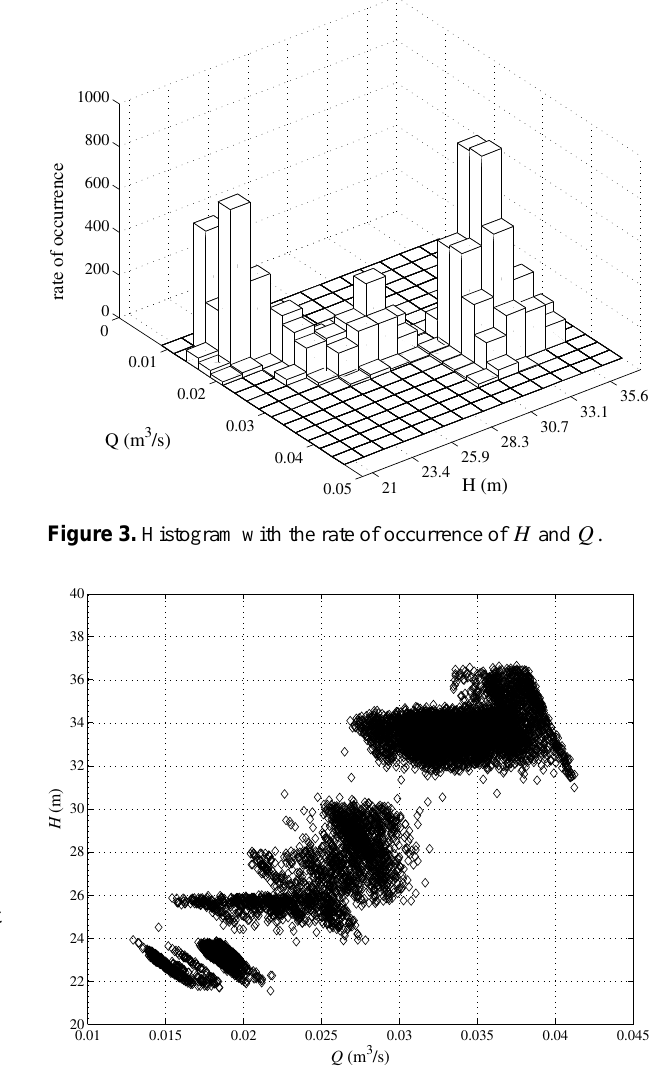
Figure 4. Pump head, H , vs. pump flow, Q